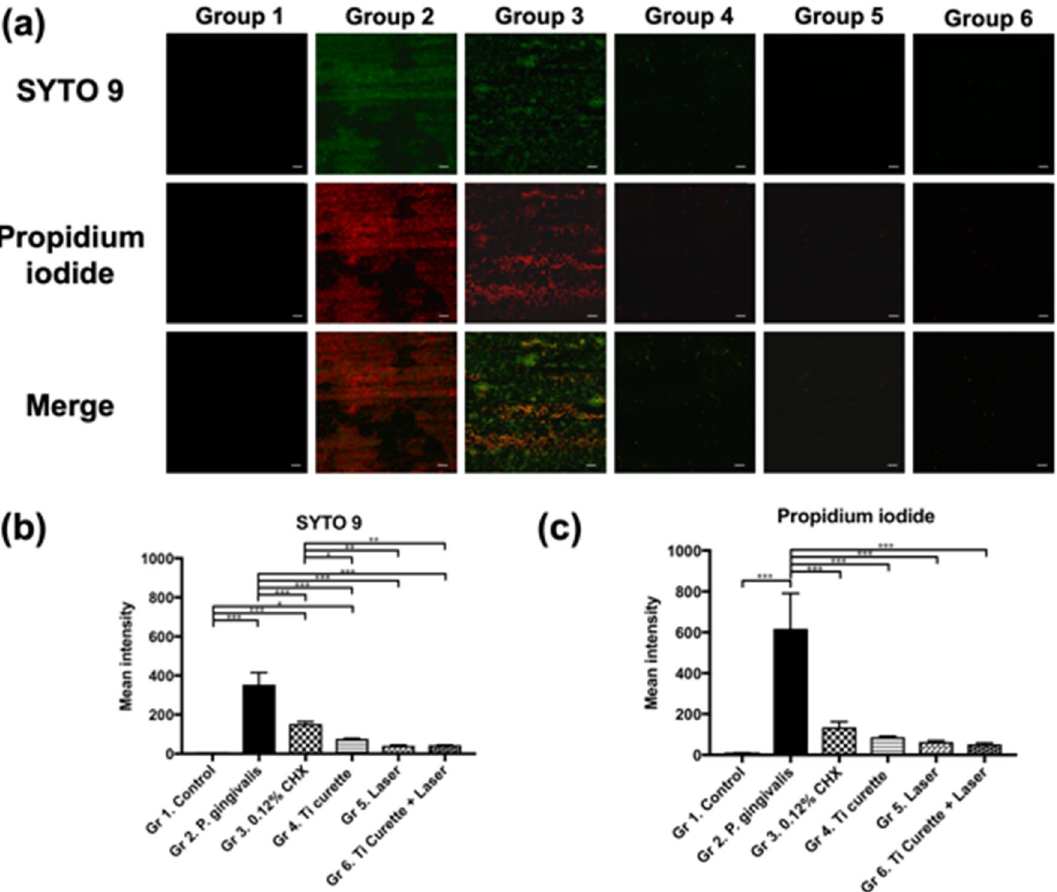
Figure 4. ( a ) Representative fluorescence microscopy images (× 63) with live (green; SYTO9)/dead (red; propidium iodide) staining of P. gingivalis ATCC 33277 adhesion on rough titanium disc surfaces after different treatments. Each image was taken with the same × 63 object lens with oil and z-stacked for comparison. Scale bar, 10 μm (white). ( b ) Mean intensity of SYTO 9 and ( c ) propidium iodide after various treatments. * p < 0.05 ** p < 0.01 *** p < 0.001.